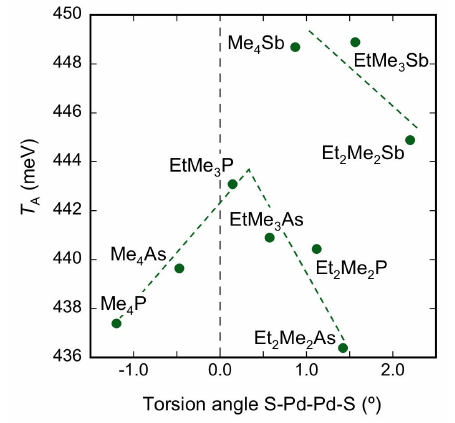
Figure 16. Mapping of intradimer HOMO-HOMO transfer integrals T S–Pd–Pd–S ( Ф